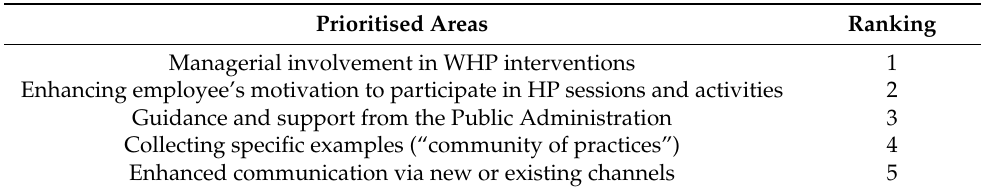
Table 2. Areas prioritised by the Local Implementation Working Group, where strategic action was considered most needed, ranked in order or